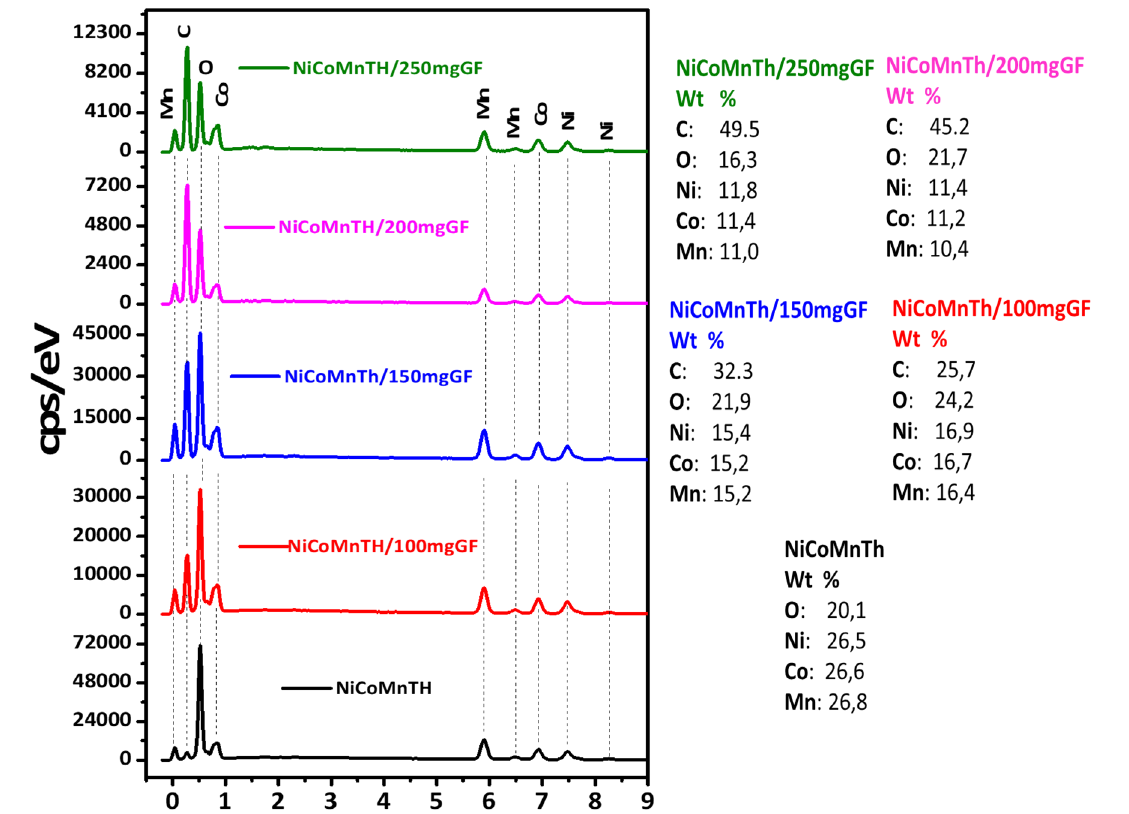
Fig. 4 EDX elemental composition of NiCoMn-TH (pristine), NiCoMn TH/100 mg GF, NiCoMn-TH/150 mg GF, NiCoMn-TH/200 mg GF, and NiCoMn-TH/250